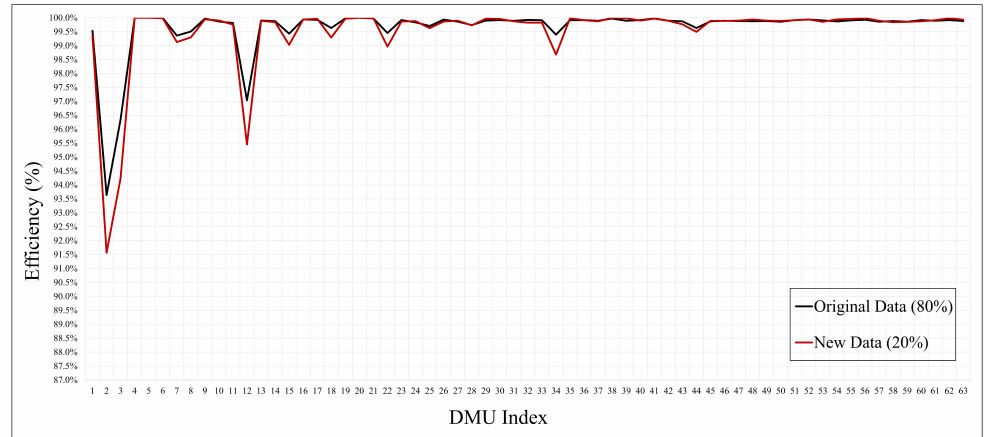
Figure 4. Feature efficiency of the original data (80%) and new data (20%) of each